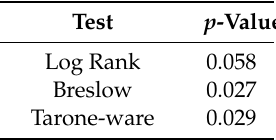
Table 2. Kaplan-Meier analyses. Kaplan–Meier analyses between cluster 1 and cluster